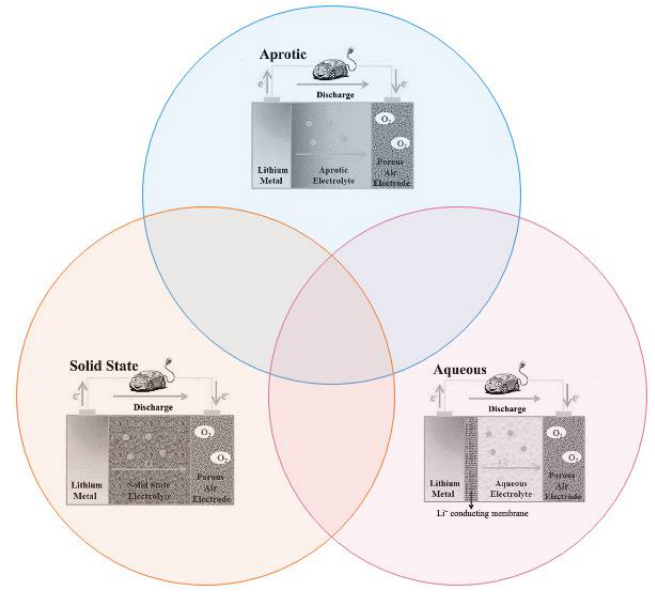
Figure 4. Different types of lithium air batteries.